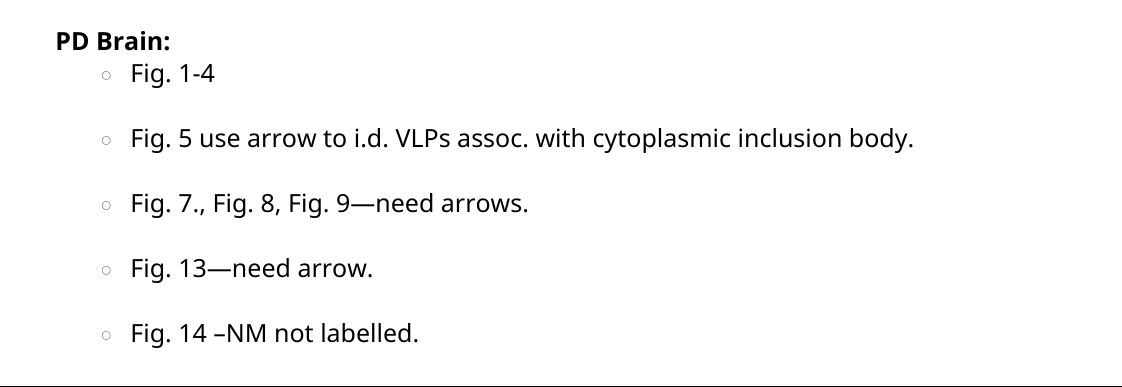
Fig. 14 –NM not labelled.